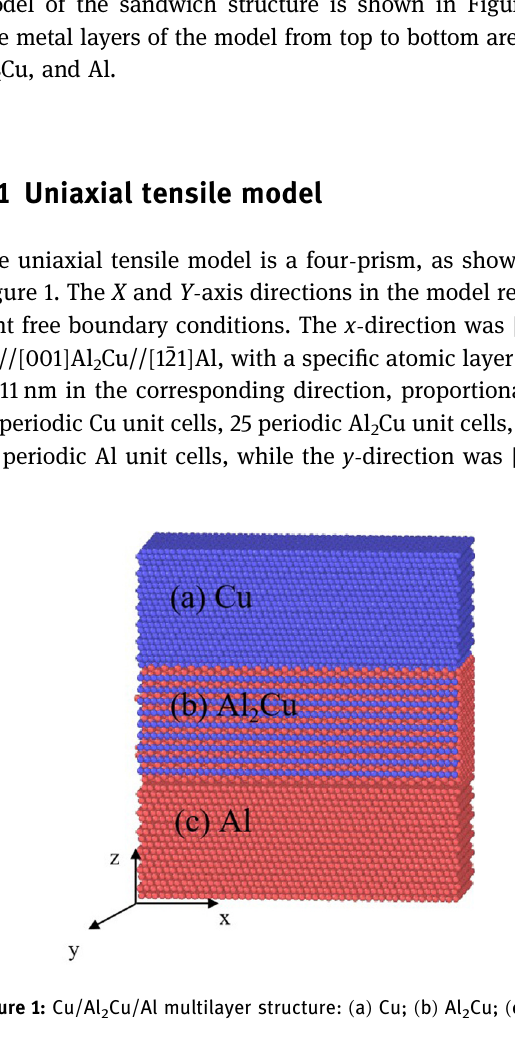
Figure 1: Cu/Al 2 Cu/Al multilayer structure: ( a ) Cu; ( b ) Al 2 Cu; ( c )